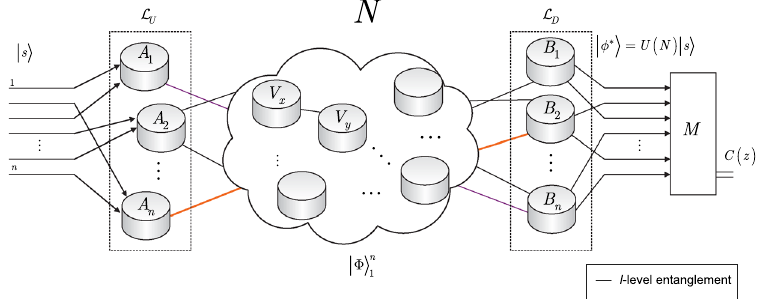
. . . s input system is distributed via | � = |+� 1 |+� n 1 1 ( ) , 0 1 z s z , while is an n -qubit z | √ 2 √ 2 n | � |+� = | � = | � + | � � (cid:31)